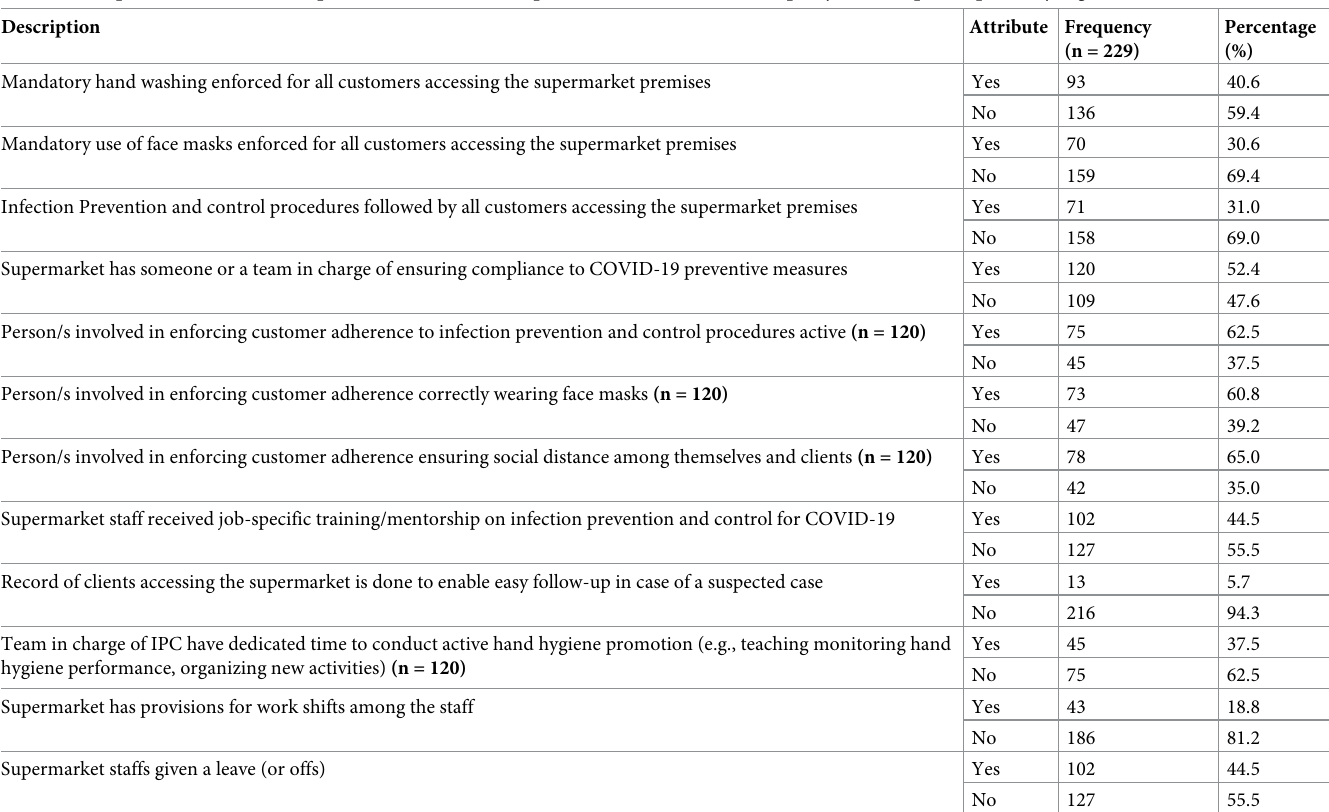
Table 2. Compliance with COVID-19 prevention measures in supermarkets in Mukono municipality and Kampala Capital City, Uganda.